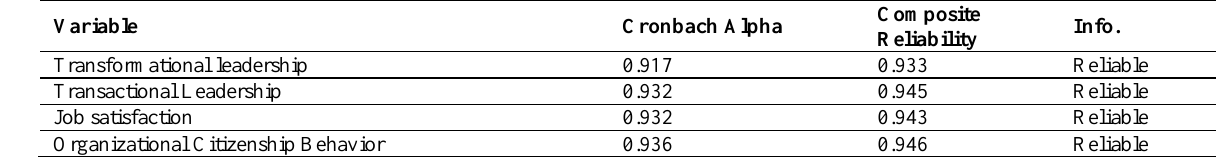
Table 4: Results of Composite Reliability and Cronbach